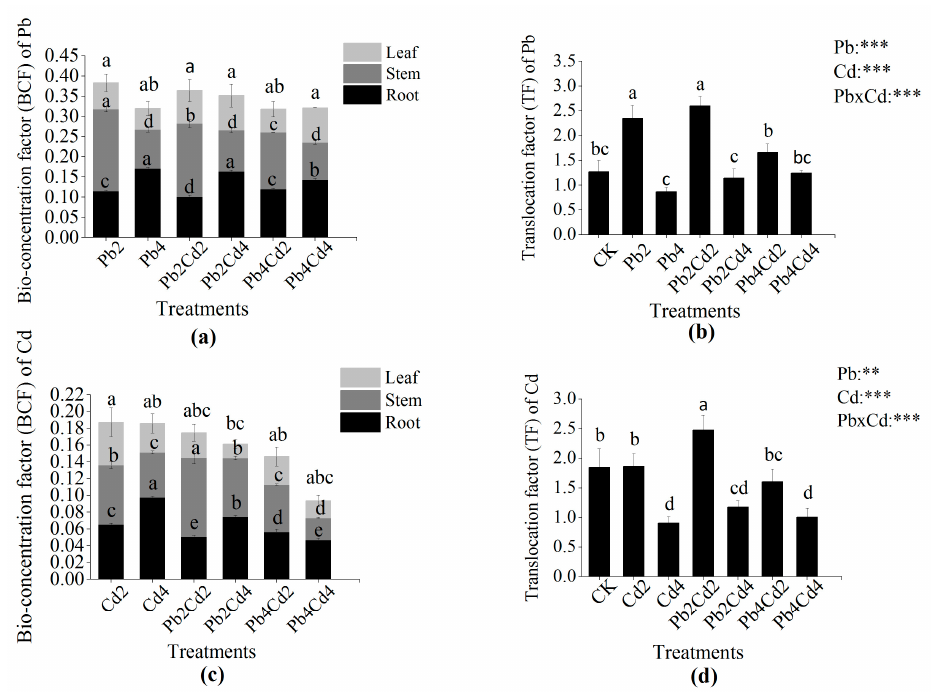
Figure 4. Effects of individual and combined Pb and Cd stress on Pb and Cd accumulation and translocation characteristics of F . parvifolia . ( a ) The bio-concentration (BCF) of Pb in plant different tissues. ( b ) The translocation (TF) of Pb in plant shoot. ( c ) The BCF of Cd in plant different tissues. ( d ) The TF of Cd in plant shoot. The post hoc test used for the estimation of the significance level is the Duncan test. Different lowercase letters indicate significant differences at p < 0.05 between treatments. Each value represents mean values ± SEs (n = 5). **, p < 0.01; ***, p < 0.001.